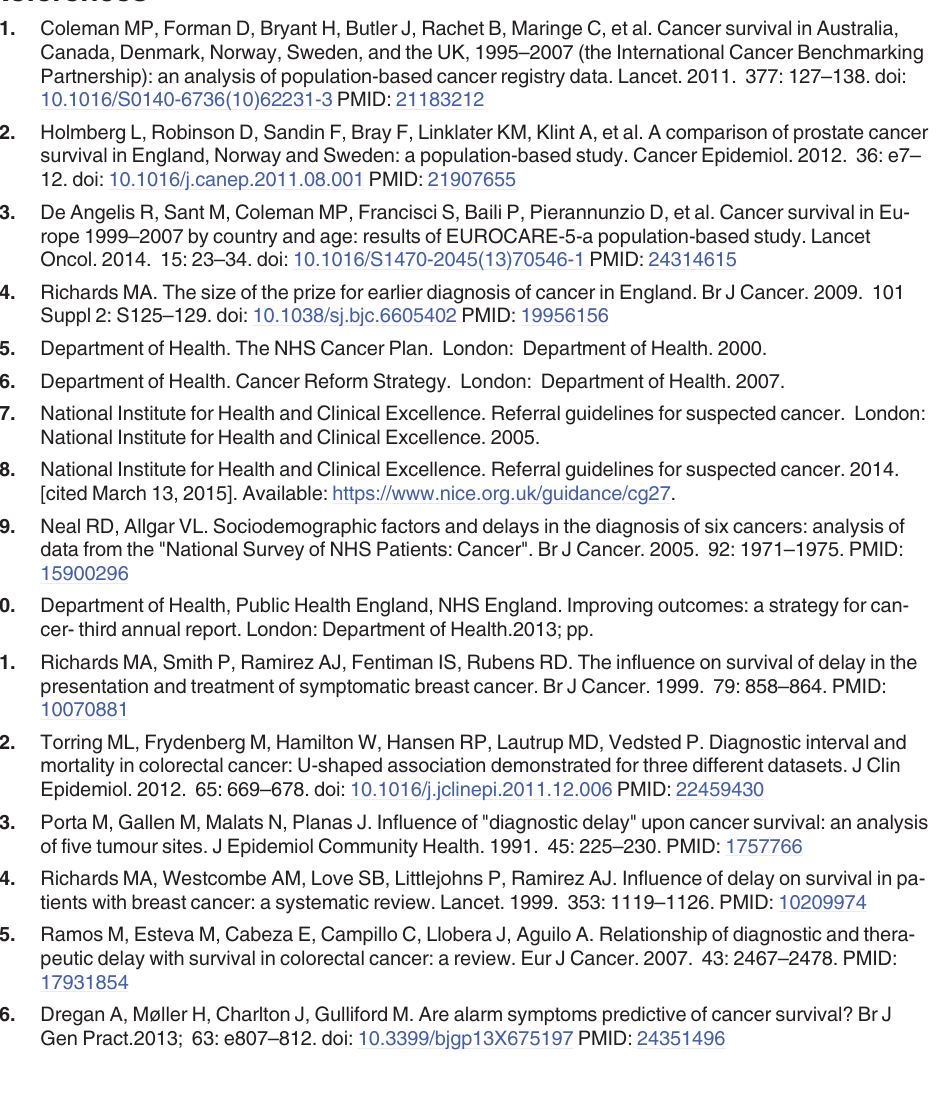
S3 Table. Presenting symptoms of colorectal cancer patients and diagnostic interval. S4 Table. Presenting symptoms of lung cancer patients and diagnostic interval. S5 Table. Presenting symptoms of prostate cancer patients and diagnostic interval. S6 Table. Multivariable analysis for